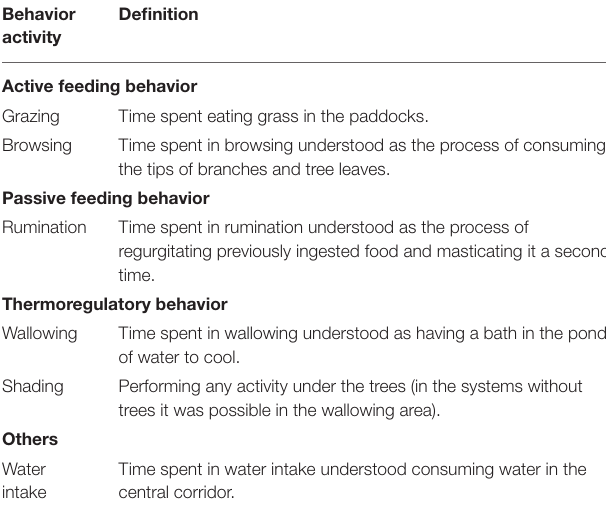
TABLE 2 | Description of recorded activities. TABLE 3 | Fodder offered and grazing pressure in Silvopastoral system and